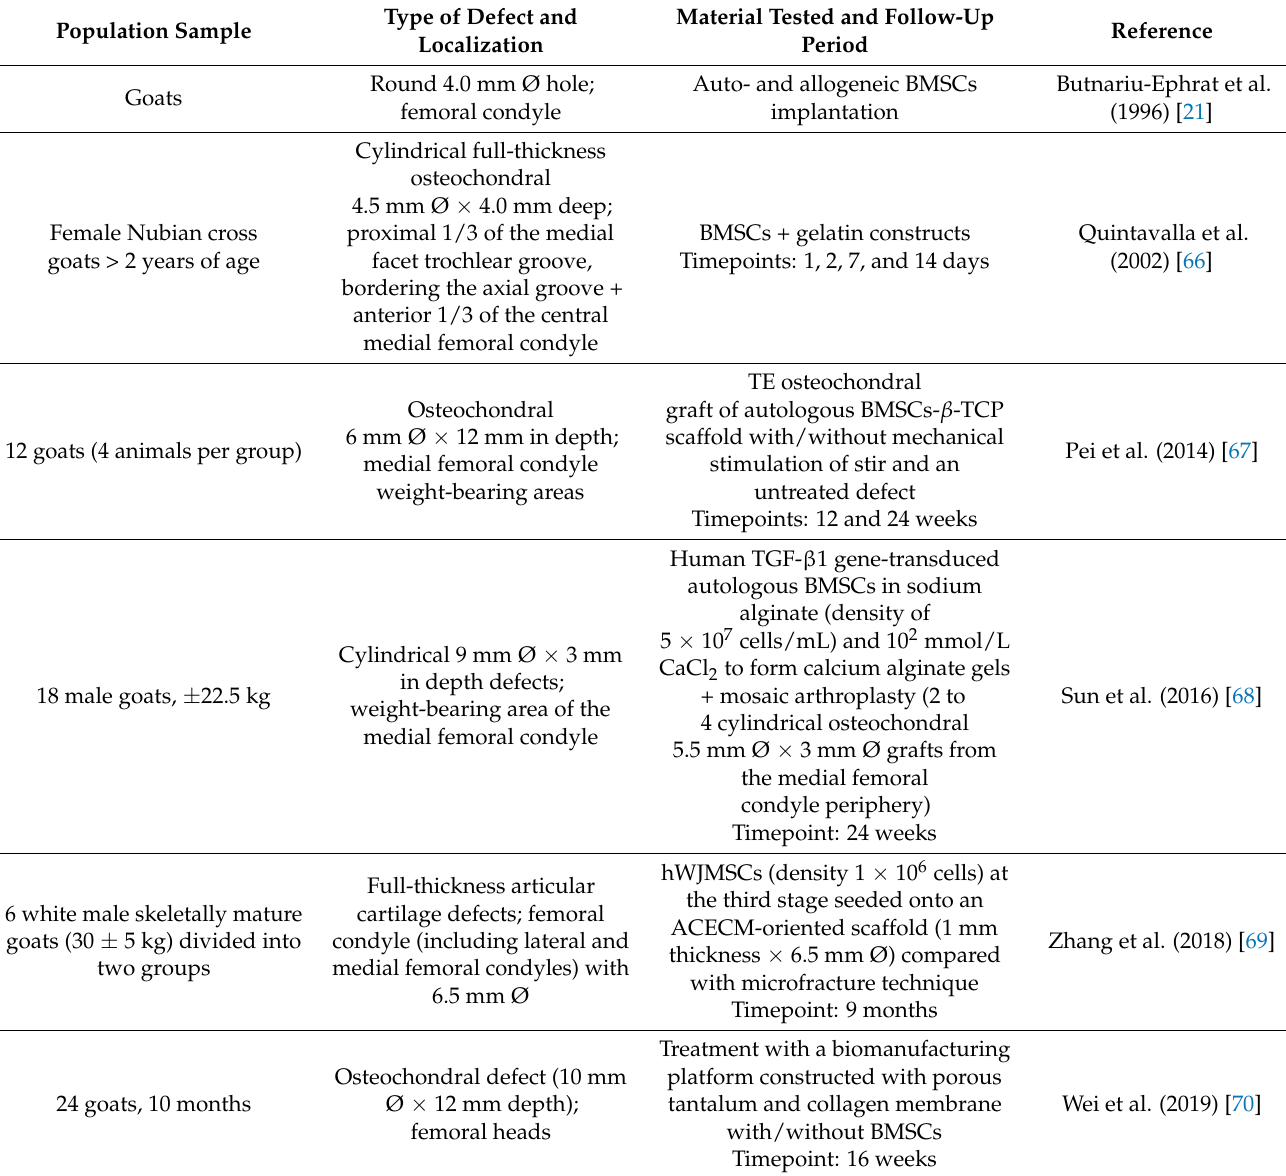
Table 2. MSCs studies in the caprine model for cartilage